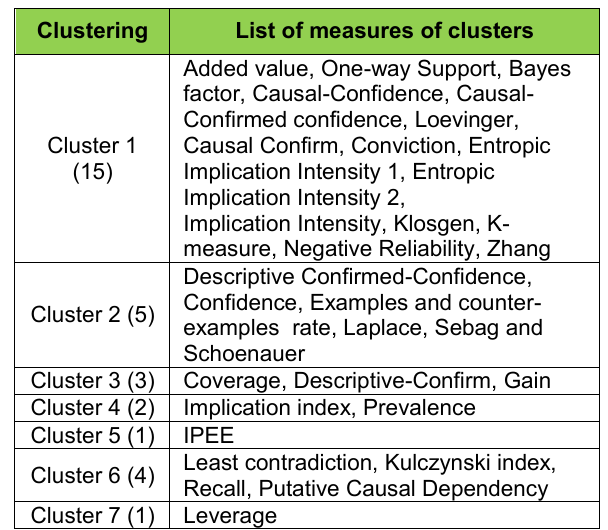
Table 3: The clustering results of measures based on Manhattan distance